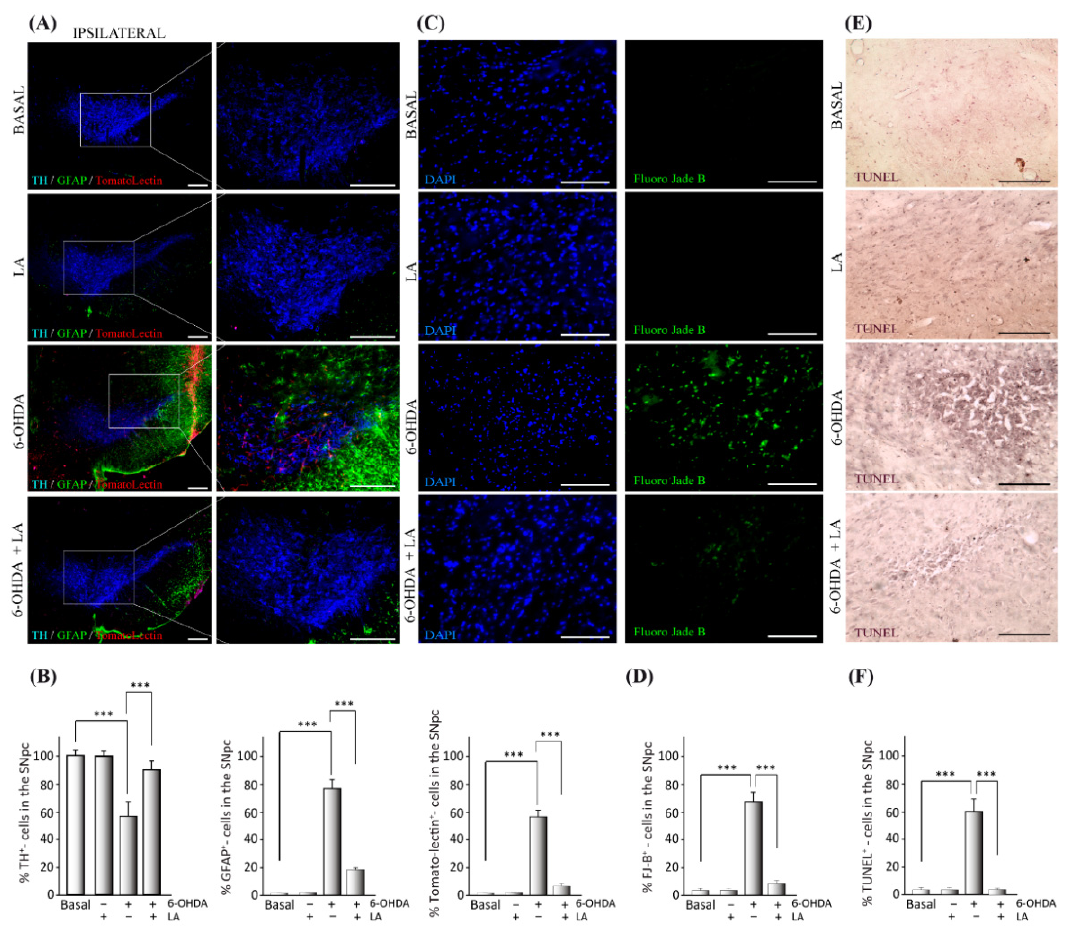
Figure 1. Neuroprotective effect of LA on a hemi-Parkinsonian animal model. Animals were injected unilaterally with 6-OHDA in the SNpc in combination or not with LA. The epifluorescence microscope images are ipsilateral coronal sections containing SNpc samples from the different experimental groups. ( A ) Representative images of the SNpc showing the presence of dopaminergic neurons labeled with tyrosine hydroxylase (TH, blue); astroglial cells stained with glial fibrillary acidic protein (GFAP, green) and Tomato lectin (red) as a marker for activated microglial cells. Scale bar, 200 µ m. The right columns show greater magnification of the area delimited in the images in the left column (100 μ m). ( B ) Quantification of the number of dopaminergic, astrocyte, and microglial cells shown in (A). ( C ) Analysis of the presence of degenerating neurons (green) in the SNpc measured using Fluoro-Jade B staining (DAPI was used as a nuclear stain). Scale bar, 100 μ m. ( D ) Quantification of the number of Fluoro-Jade B (FJ-B) cells shown in ( C ). ( E ) Apoptotic neurons in the SNpc measured by the TUNEL assay. Scale bar, 100 μ m. ( F ) Quantification of the number of TUNEL-positive cells in ( E ). The values in ( B , D , F ) represent the mean ± SD, expressed as the percentage of positive cells in the SNpc, given a particular marker, from three different experiments. There were four animals/experiment/experimental group and five independent sections per animal. *** p < 0.001. Next, we studied the anti-inflammatory effect of LA in the in vivo PD model through immunohistochemical assays against the pro-inflammatory markers cyclooxygenase-2 (COX-2) and tumor necrosis factor α (TNF- α ). The presence of COX-2 and TNF- α in the SNpc (localized with the TH marker) significantly decreased in the in vivo PD model treated with LA compared with nontreated animals (Figure 2). This decrease in proinflammatory markers was accompanied by reduced signals from reactive